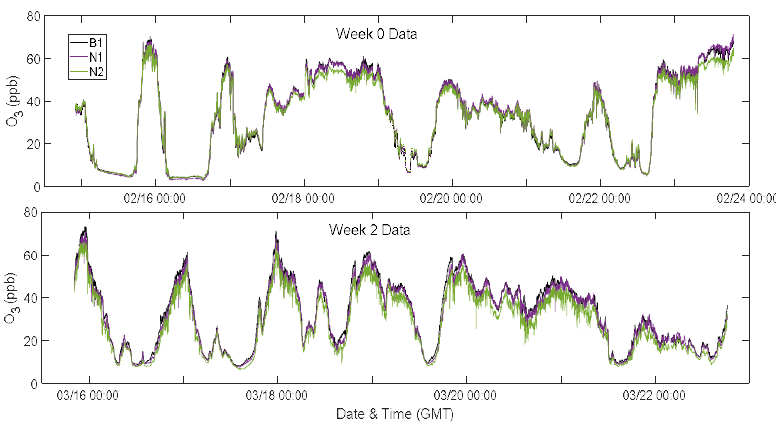
Figure A2. Time series of co-located ( top ) and deployed ( bottom ) Y-Pods, for examining neighborhood-scale variability of CO 2 .